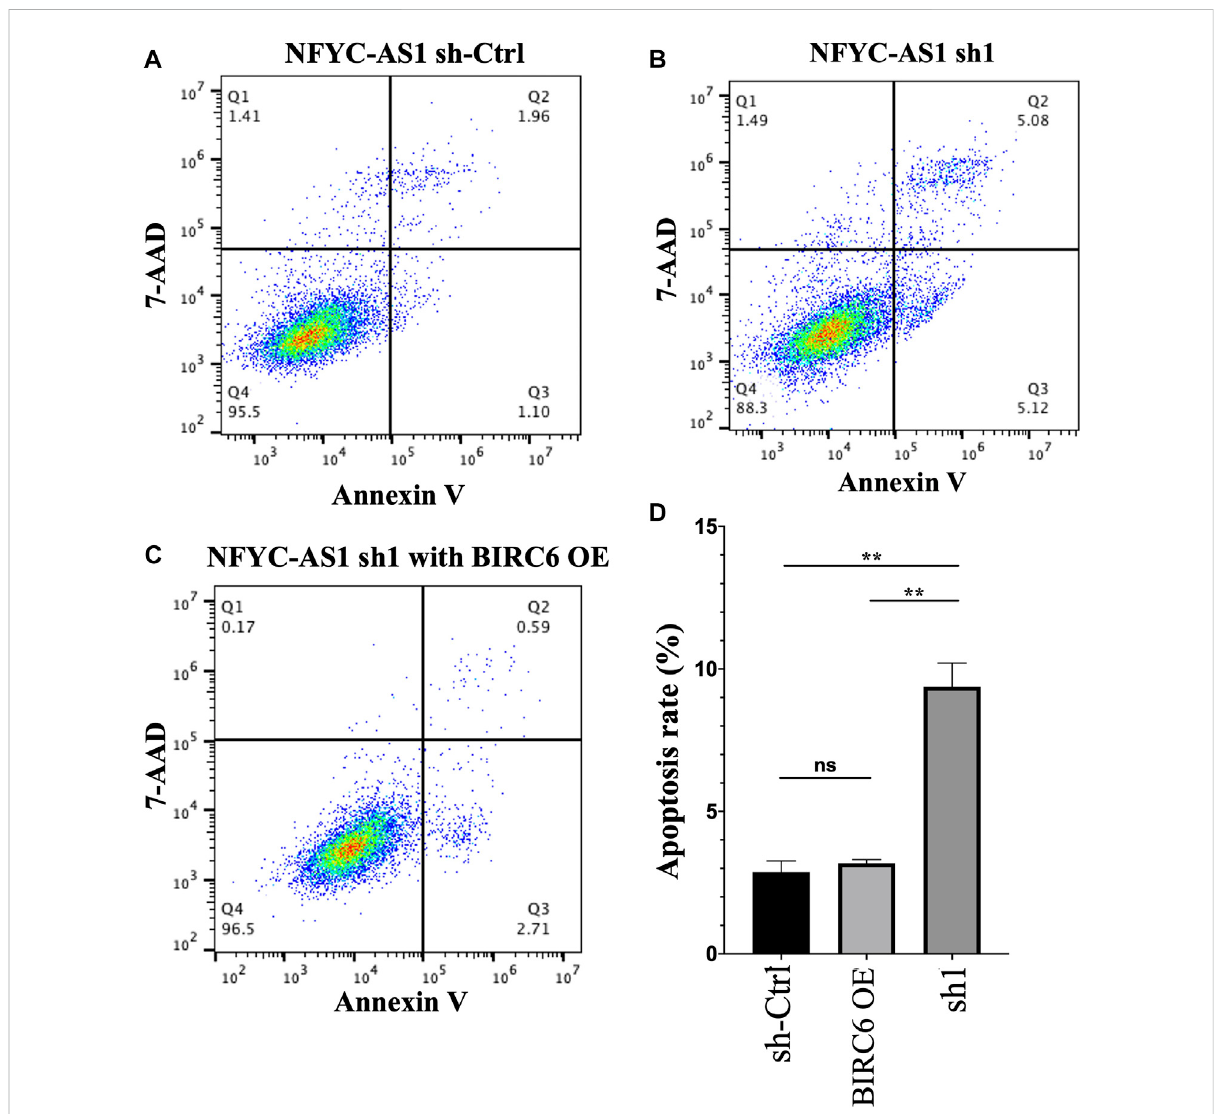
FIGURE 14 The in fl uence of NFYC-AS1 on the apoptosis of A549 cells. (A) Representative fl ow cytometry analysis of apoptosis in A549 cells without the knockdown of NFYC-AS1 expression. (B) Representative fl ow cytometry analysis of apoptosis in A549 cells with the knockdown of NFYC-AS1 expression. (C) Representative fl ow cytometry analysis of apoptosis in A549 cells with the knockdown of NFYC-AS1 expression combined with the rescue of BIRC6 expression. (D) Statistic results of apoptosis rate in A549 cells with or without the knockdown of NFYC-AS1 expression or combining the NFYC-AS1 knockdown with BIRC6